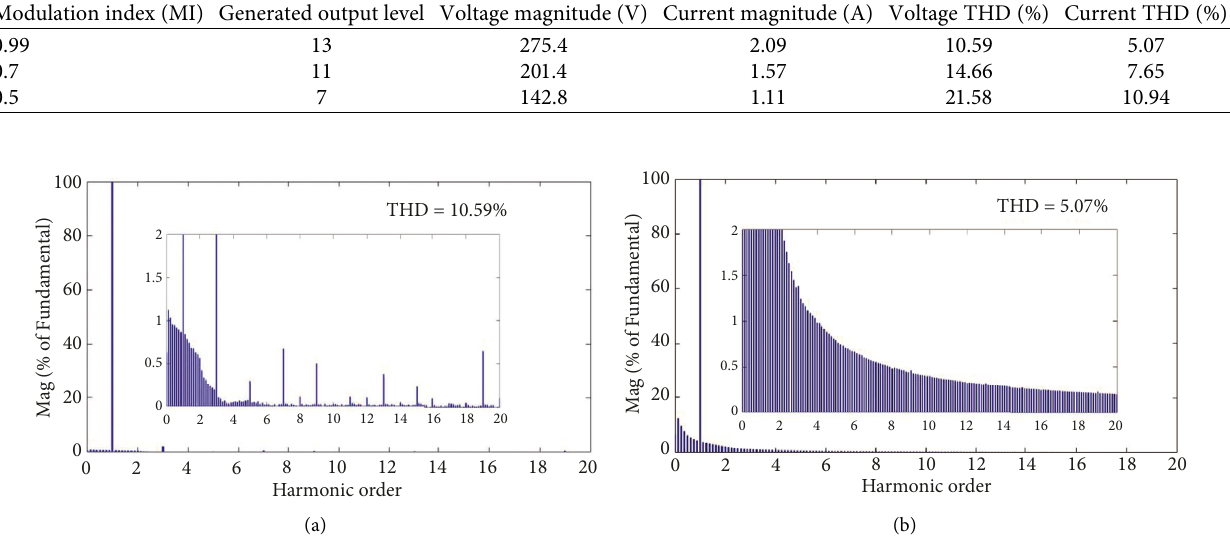
Figure 13: THD analysis (MI-0.99). (a) Voltage THD, (b) current THD.